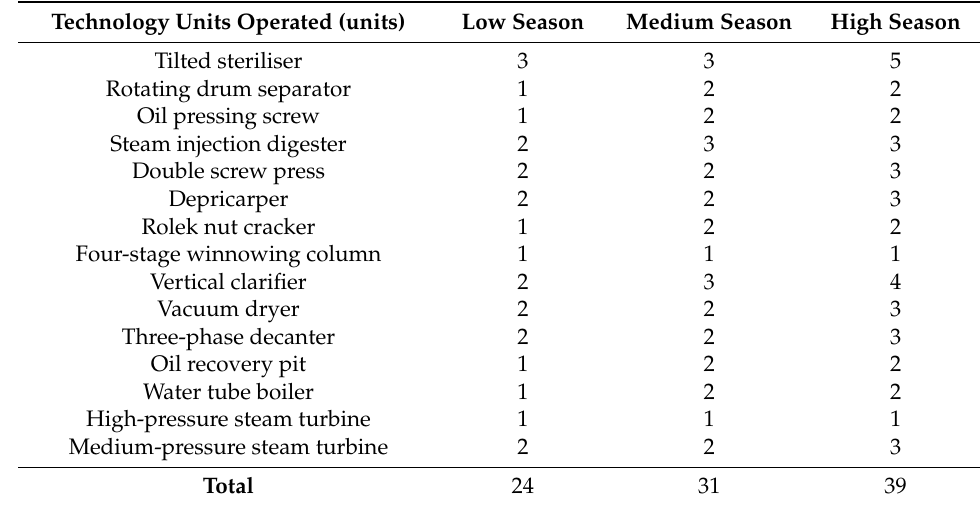
Table 4. Technology units operated for baseline POM